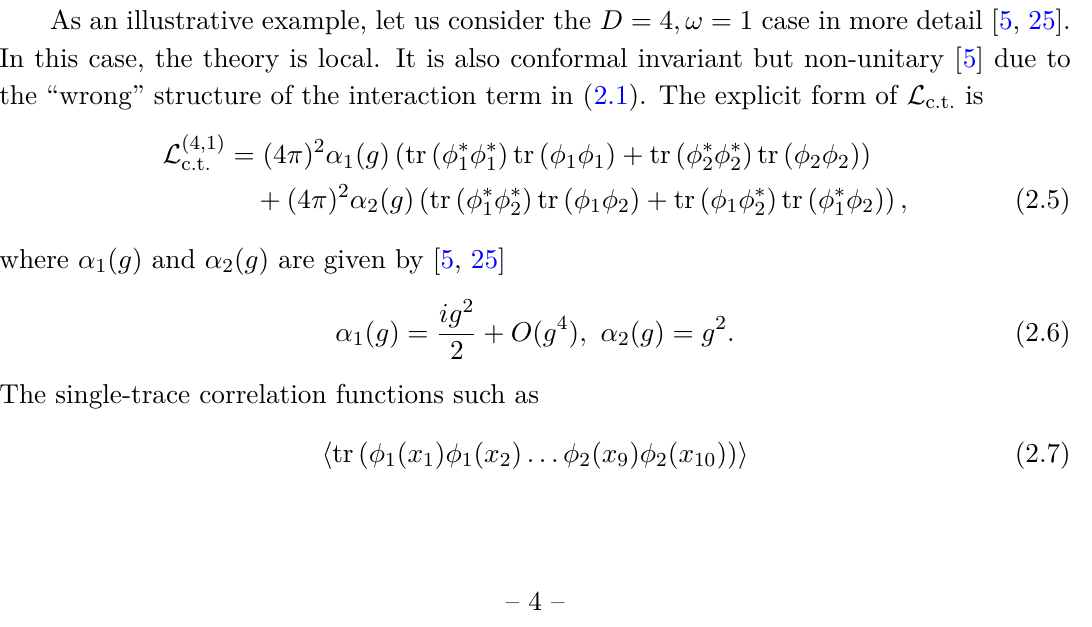
Figure 2 . Examples of fishnet graphs. A) graph corresponds to the only one contribution to the single-trace 10-point correlation function h tr ( φ The propagators of the φ contribution to the single-trace 8-point correlation function h tr ( χ ( x ω = 1 model. Dots on the lines correspond to the non-standard power of the propagator of the χ field ( 1 /x 2 in coordinate space, which translates to 1 /p 4 in momentum